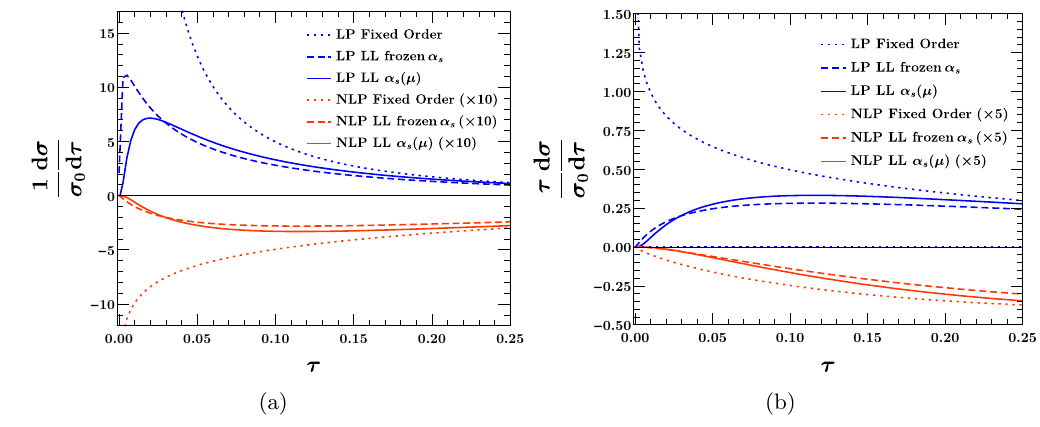
Figure 2 . Plots of the LP and NLP (cid:12)xed order and resummed predictions for thrust in pure glue H ! gg , with and without running coupling. In a) we show d(cid:27)=d(cid:28) and in b) we show (cid:28)d(cid:27)=d(cid:28) . Resummation at LP cures a 1 =(cid:28) divergence, while resummation at NLP overturns a much weaker logarithmic divergence, leading to a broader